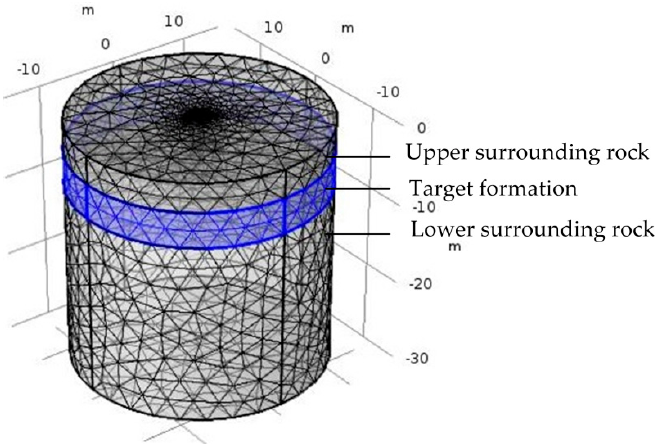
Figure 13. Three-layer formation model.